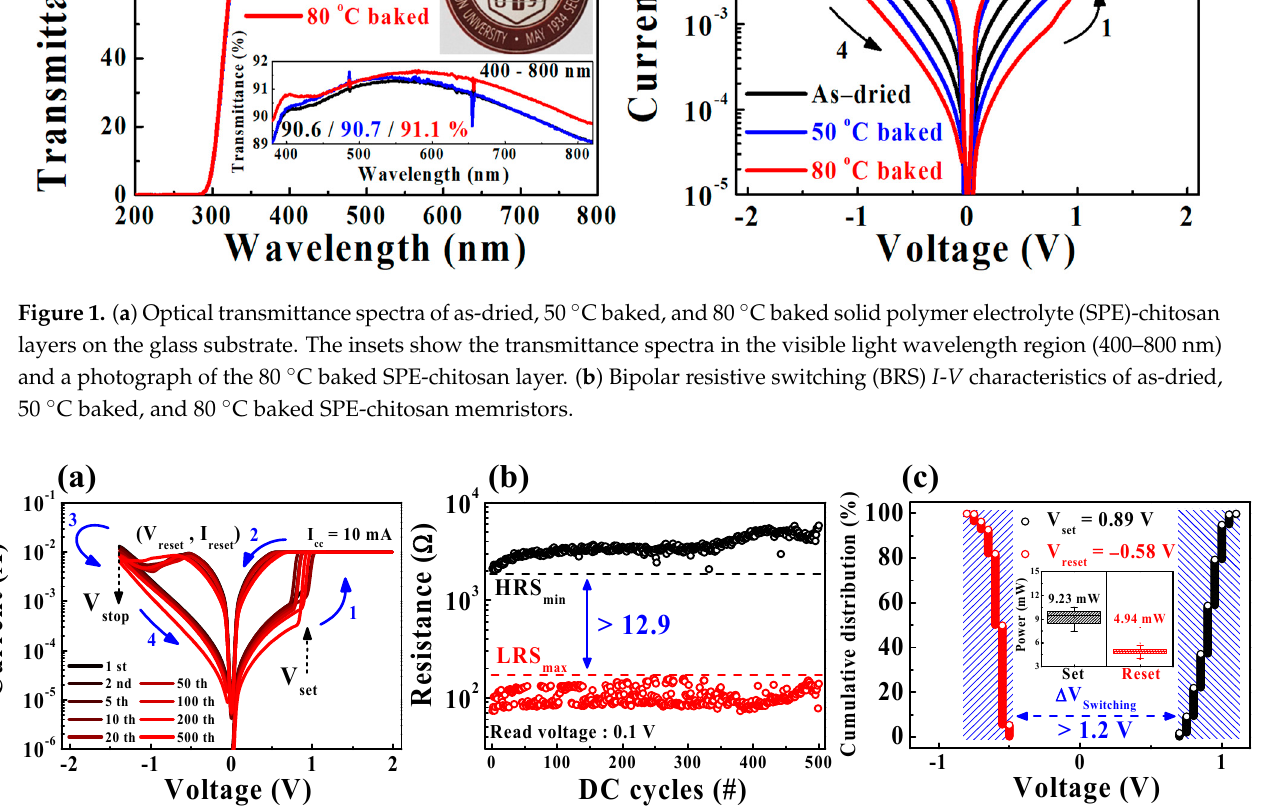
Figure 2. RS endurance characteristics for 5 × 10 2 DC cycles of 80 °C baked SPE-chitosan memristors. ( a ) BRS I - V characteristics. ( b ) Resistance values of a low-resistance state (LRS) and high-resistance state (HRS) extracted at a read voltage of 0.1 V. ( c ) Cumulative distribution of the set and reset operating voltages. The inset depicts the calculated set and reset operating powers.